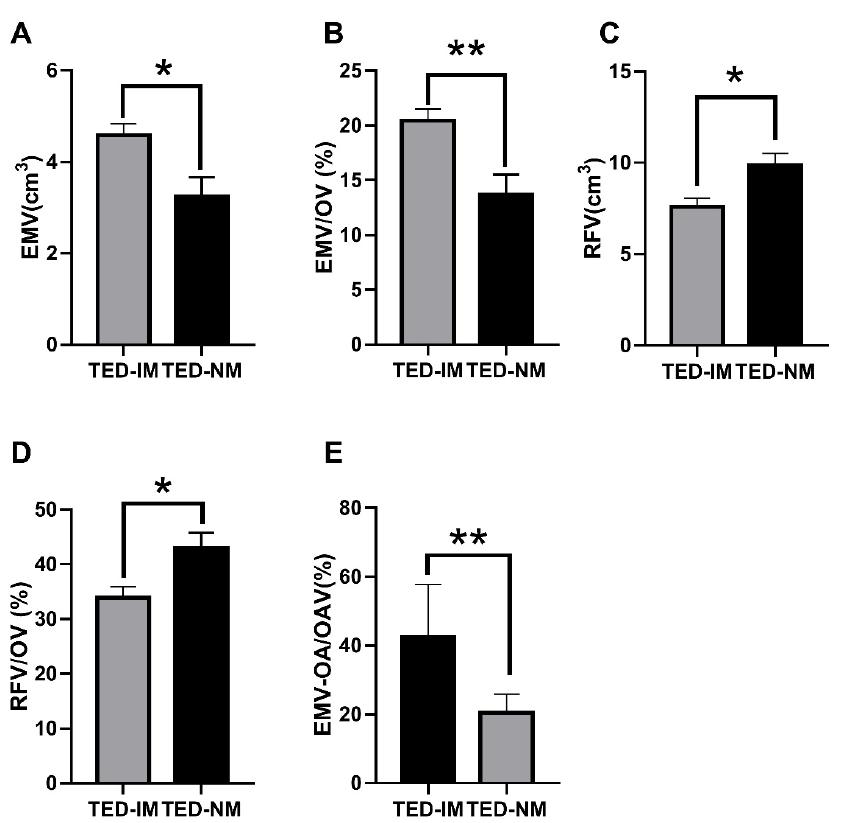
Figure 3. The comparison of the soft tissue volumes between TED-IM and TED-NM groups. ( A ) EMV, ( B ) EMV/OV, ( C ) RFV, ( D ) RFV/OV, and ( E ) EMV-OA/OAV (* p < 0.05, ** p < 0.01).